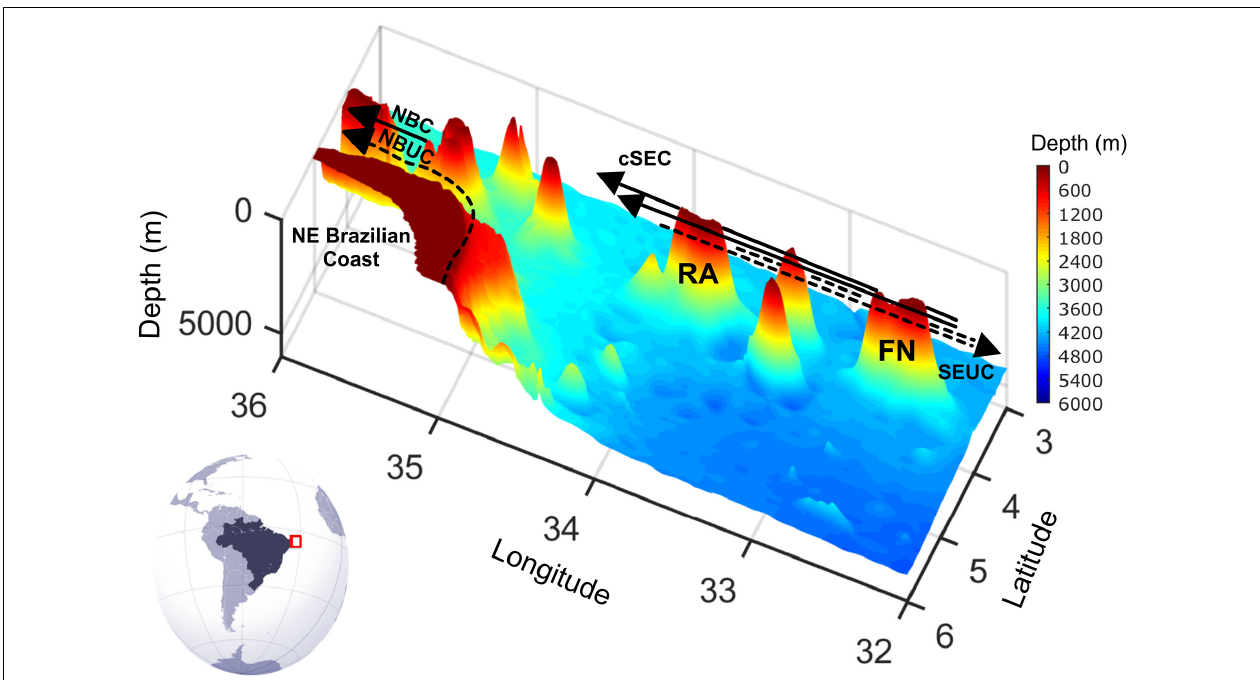
FIGURE 1 | Map of the study area in the western Tropical Atlantic Ocean off northeast Brazil (also indicated by the red box on the globe). General bathymetric (colour scale) is shown at 0–6,000 m depth. Surface and subsurface currents are represented by solid and dashed lines, respectively. RA, Rocas Atoll; FN, Fernando de Noronha Archipelago; cSEC, central branch of the South Equatorial Current, SEUC, South Equatorial Undercurrent, NBC, North Brazil Current; NBUC, North Brazil